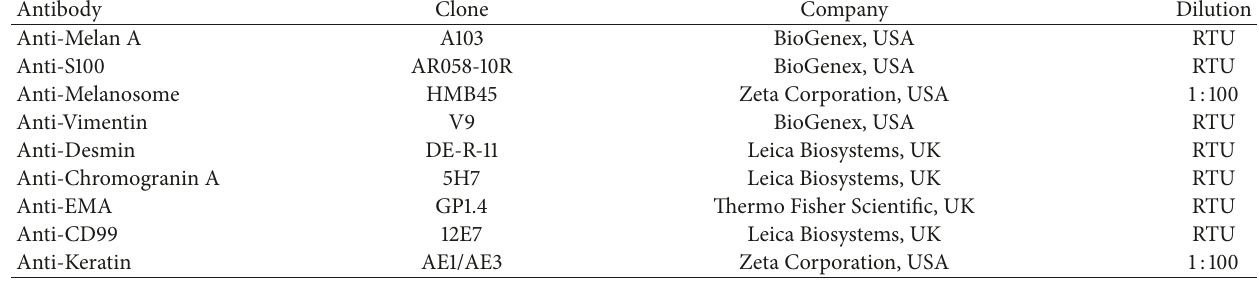
Table 1: Panel of antibodies used in the present case report. RTU: ready to use.